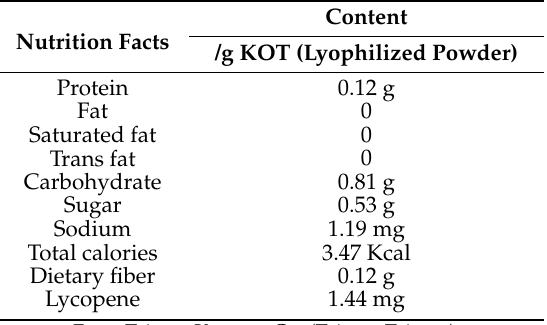
Table 1. Nutrition facts of tomato juice from Kagome Ltd. (KOT) (per g lyophilized powder).